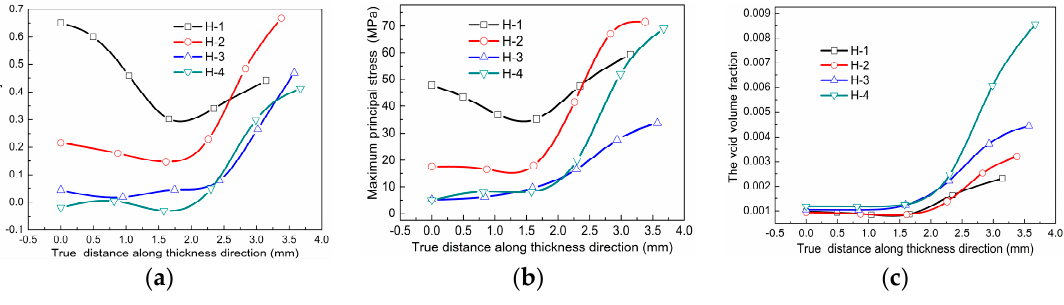
Figure 13. Distributions of ( a ) stress triaxiality; ( b ) maximum principal stress and ( c ) VVF in tube along the different radial paths.